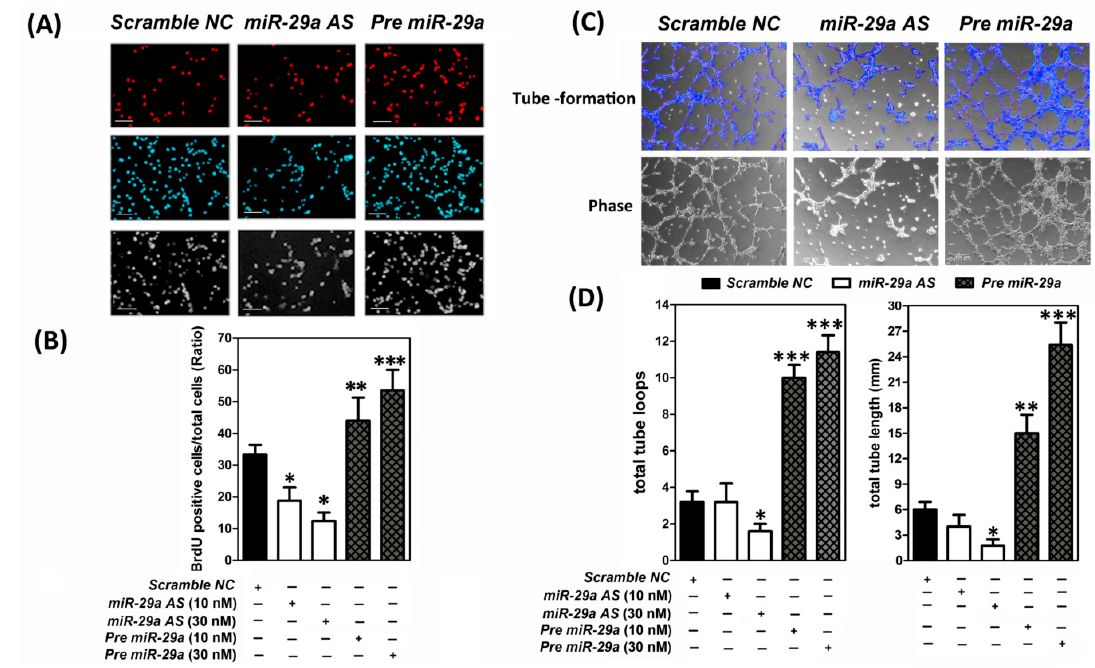
Figure 2. MicroRNA-29 overexpression augmented the human umbilical vein endothelial cells Human Umbilical Vein Endothelial Cells (HUVECs) proliferation and capillary-like tube formation in vitro ( n = 6). ( A ) Representative pictures showed the DNA newly replication in HUVECs. HUVECs were plated in a 24-well plate and cultured until sub-confluency, and then transfected with Pre miR-29a precursor (also termed Pre miR-29a ), miR-29a antisense (also termed miR-29a AS ), or scrambled negative control (NC) at a final concentration of 10 or 30 nM for 24 h, according to the manufacturer’s instructions. 5-Bromo-2-Deoxyuridine (BrdU) (100 µg/mL) was added to culture media 8 h before cells were fixed for BrdU staining. BrdU-positive cells (defined as the neo-proliferating cells) were stained by a cell proliferation assay kit as described in Materials and Methods Section 4.6. and shown in red nuclei fluorescence. ( B ) Nine–twelve microscopic fields were randomly selected to estimate the BrdU-positive cells and shown in histograms. Forced introduction of miR-29a notably promoted HUVECs proliferation, to the cells transfected with Scrambled NC. At least 500 cells were counted and quantified in each treatment group. Each reaction was performed in triplicate and the results were similar. Data were given as means ± SD. Scale bar, 100 µ m. ( C ) HUVECs were transfected with Pre miR-29a , miR-29a AS